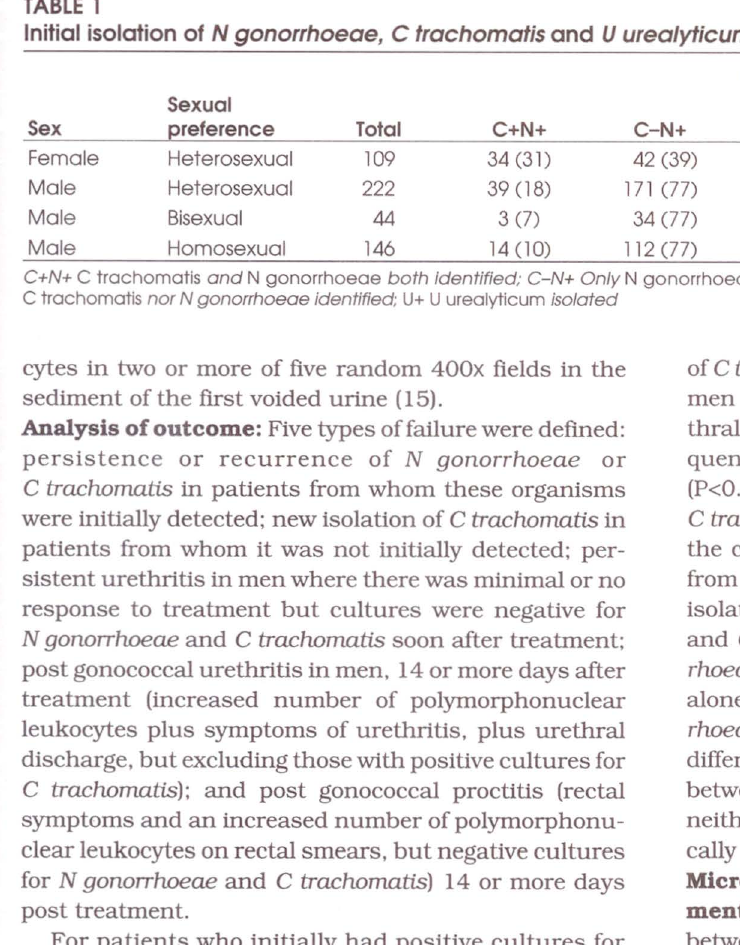
Initial isolation of N gonorrhoeae, C trachomatis and U urealyticum according to sexual